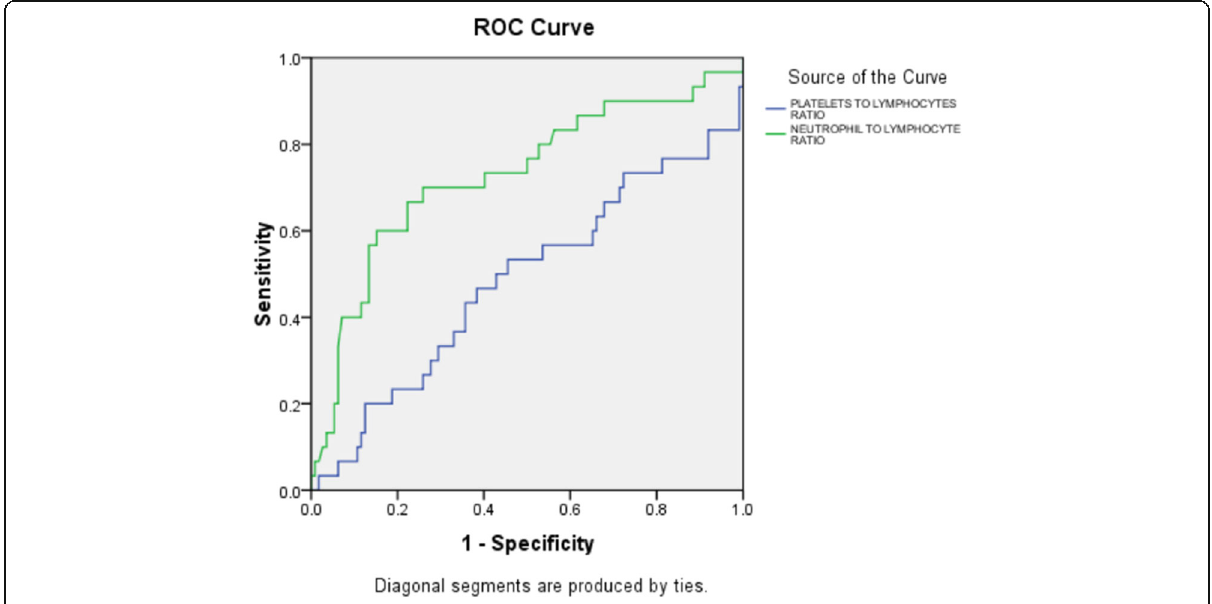
Fig. 1 ROC curve for predicting mortality using the platelet-to-lymphocyte ratio and neutrophil-to-lymphocyte ratio